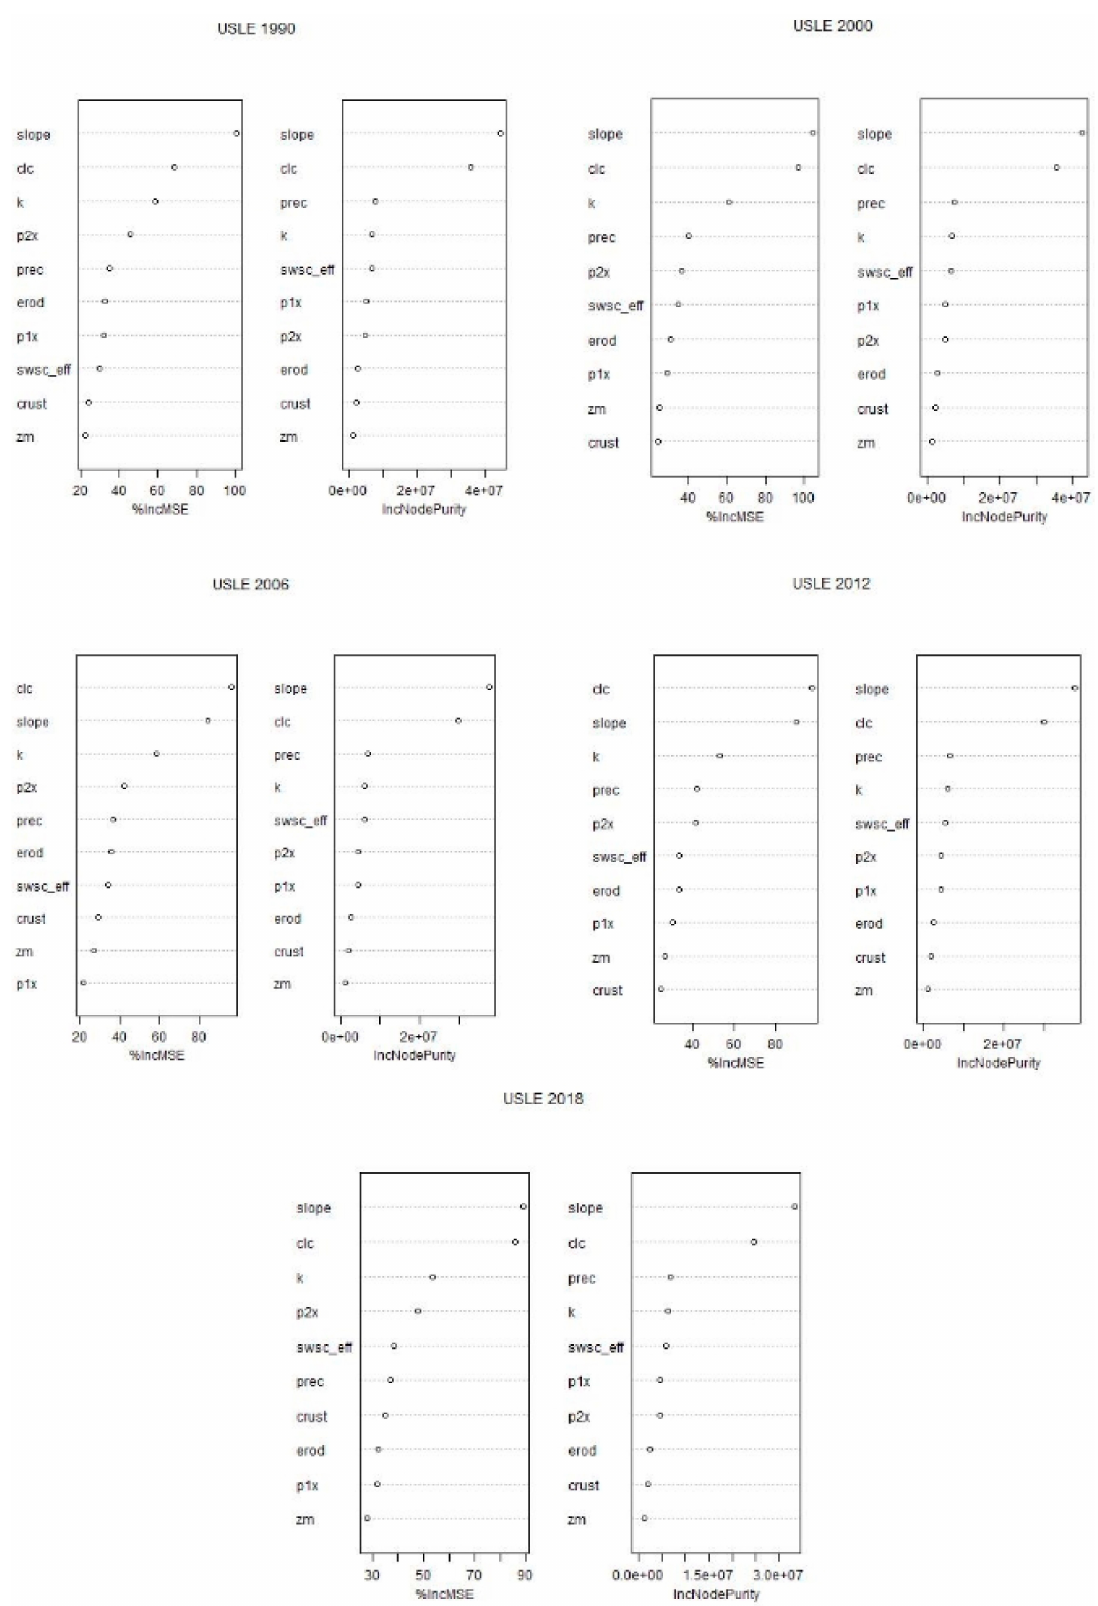
Figure A4. Variable importance based on Random Forest regression for the USLE model for all modeled